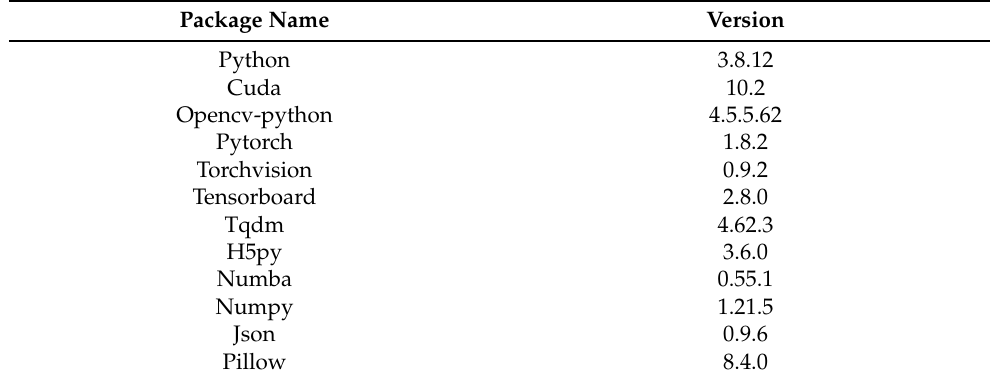
Table 1. Main installation packages required by the running environment.